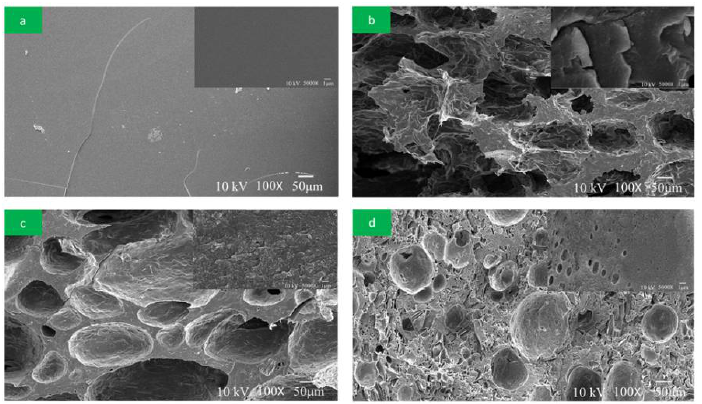
Figure 9. SEM images of the fracture surface: ( a ) (HMP), ( b ) (SF adhesive), ( c ) (SF/9% HMP adhesive), and ( d ) (SF/18% HMP adhesive).